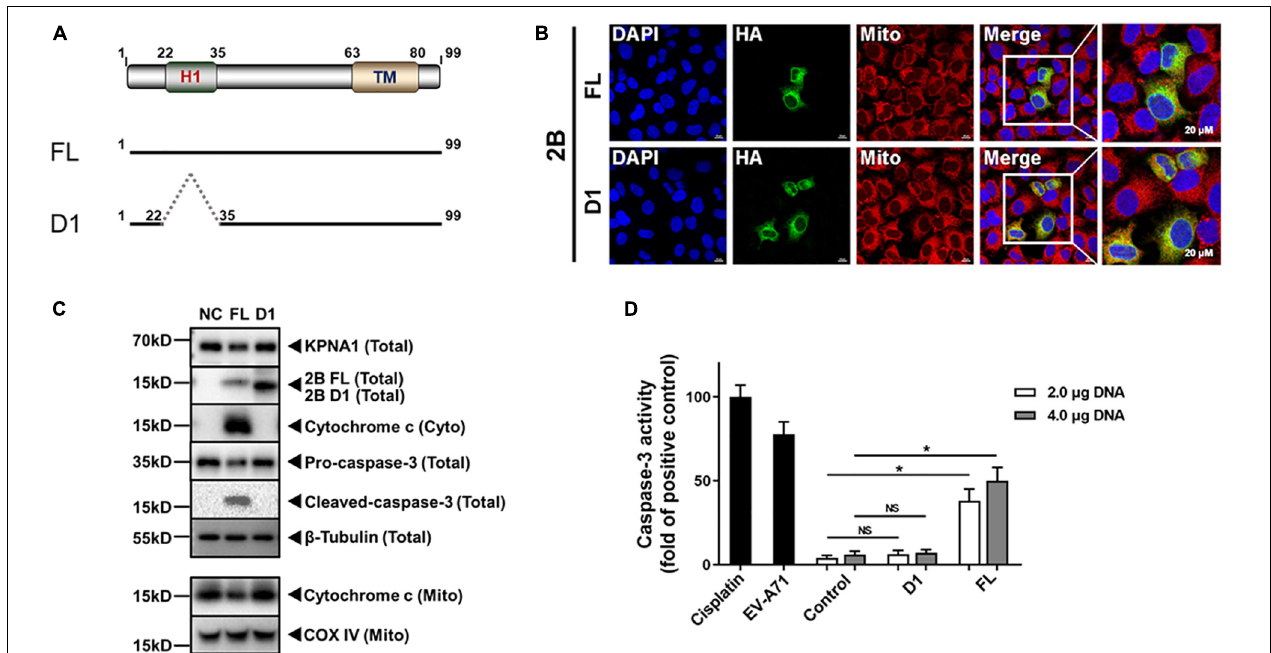
FIGURE 6 | The N-terminal H1 domain of 2B appeared to be responsible for the induced degradation of KPNA1. (A) Schematic illustration of full-length (FL) and truncated constructs (D1) of EV-A71 2B. (B) Subcellular localization of full-length and truncated D1 ( (cid:77) 22–35) 2B in cells. HeLa cells on glass slides were transfected with plasmids expressing HA-tagged full-length or truncated D1 constructs (2.0 µ g) for confocal immunofluorescence imaging with staining of antibodies for HA tag. DAPI staining was for visualizing the nuclei. Mitochondria were labeled with MitoTrackerTM Deep Red FM. Magnification, × 630. (C) Effect of the D1 deletion mutant on the release of cytochrome c and degradation of KPNA1. HeLa cells were transfected with plasmids expressing HA-tagged full length or D1 mutant (2.0 µ g). Whole cell lysates and the mitochondrial (Mito) and cytosolic (Cyto) fractions were prepared at 36 h post transfection for western blot analyses with antibodies for KPNA1, HA tag, cytochrome c , pro-caspase-3, cleaved-caspase-3, COX IV, or β -Tubulin. (D) Effect of D1 deletion on caspase-3 enzymatic activity. HeLa cells were either infected with EV-A71 or transfected with plasmids expressing full length or D1 mutant 2B (2.0/4.0 µ g). HeLa cells were treated with Cisplatin (30 µ M) as positive control. Supernatants of the cell lysates were prepared 36 h later from the cells with different treatments for measuring the enzymatic activity of caspase-3 using Ac-DEVD-pNA as a substrate. The caspase-3 activity in Cisplatin-treated cells was set as 100%. t tests were conducted between control groups and transfected groups based on the same amount of plasmid DNA used for transfection. NS, no significance; * P <